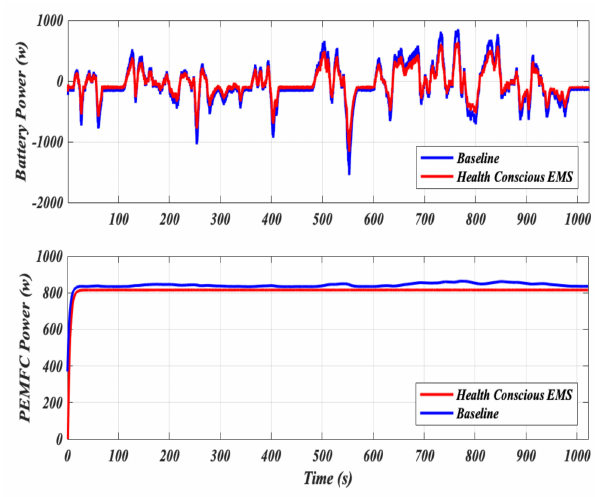
Figure 5. PEMFC and battery power for the WLTP cycle.